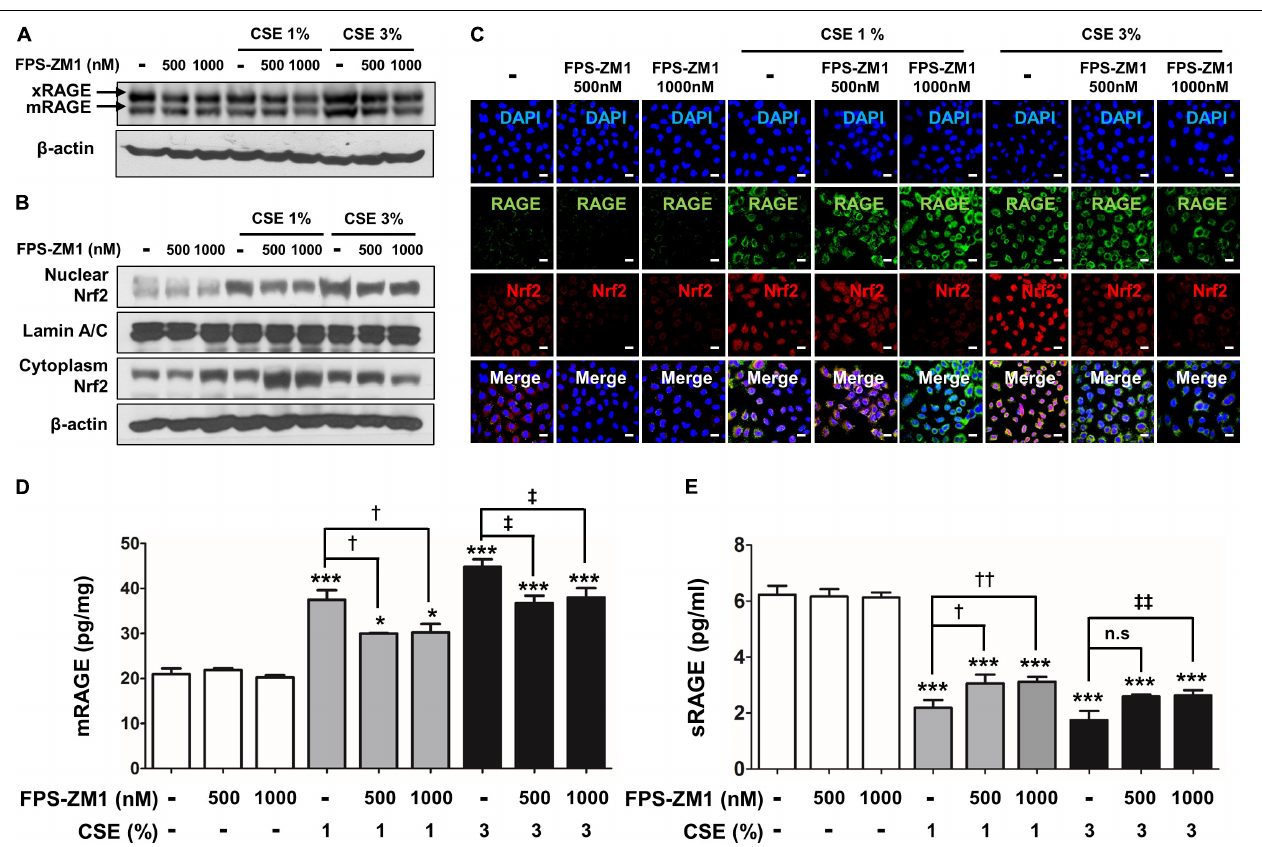
FIGURE 5 | The effect of FPS-ZM1 treatment on CSE-induced alternations of RAGE distribution through Nrf2 nuclear migration in human alveolar epithelial cells. After exposure to CSE for 8 h in the presence or absence of FPS-ZM1 for 24 h, the protein expression level of RAGE and Nrf2 was detected by western blotting, immunofluorescence or ELISA analysis. (A) Western blotting shows the expression levels of xRAGE and mRAGE, membrane-bound RAGE isoform in cell lysates. β -actin was used as loading controls. (B) The expression of Nrf2 migration from cytoplasm into nuclear location was determined by western blotting. The Lamin A/C and β -actin were used for loading control of the nuclear protein and cytoplasmic protein, respectively. (C) For each experimental group, the confocal microscopy analysis shows the protein expression of RAGE ( green ), the localization of Nrf2 ( red ) and merged images by immunofluorescence staining (magnification, × 600). DAPI is in blue . The quantitative analysis of (D) mRAGE in lung homogenates and (E) secreting sRAGE in culture supernatants of cell after CSE exposure were detected by ELISA analysis. Values are presented as the mean ± SE of three independent experiments performed in triplicate. CTL, no treatment; n.s, not significant. ∗ p < 0.05 and ∗∗∗ p < 0.001 vs. CTL; † p < 0.05 and †† p < 0.01 vs. 1% CSE treatment; ‡ p < 0.05 and ‡‡ p < 0.01 vs. 3% CSE